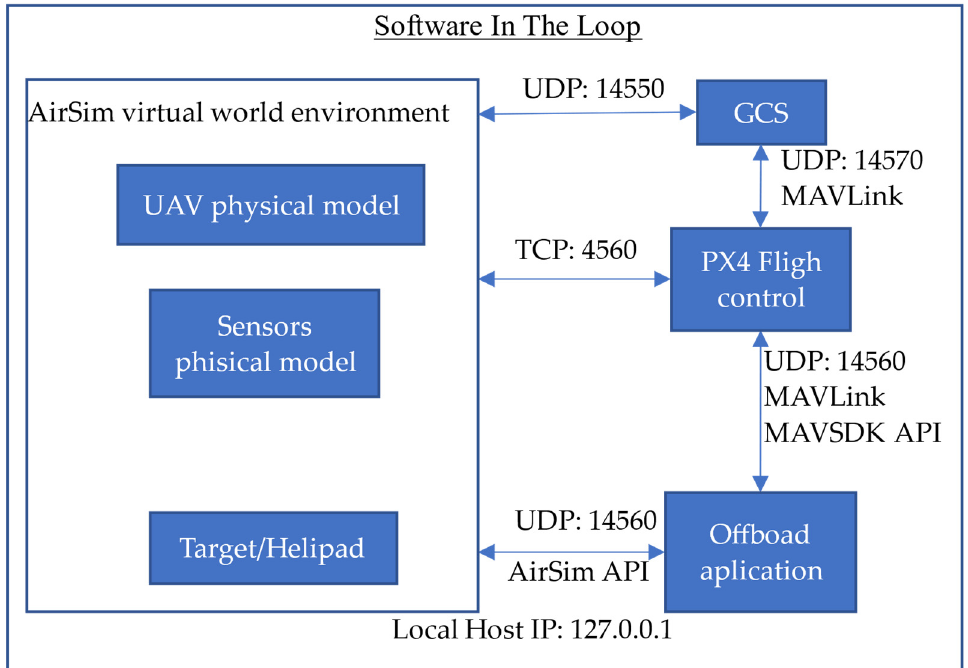
Figure 6. SITL Communication and protocol diagram.